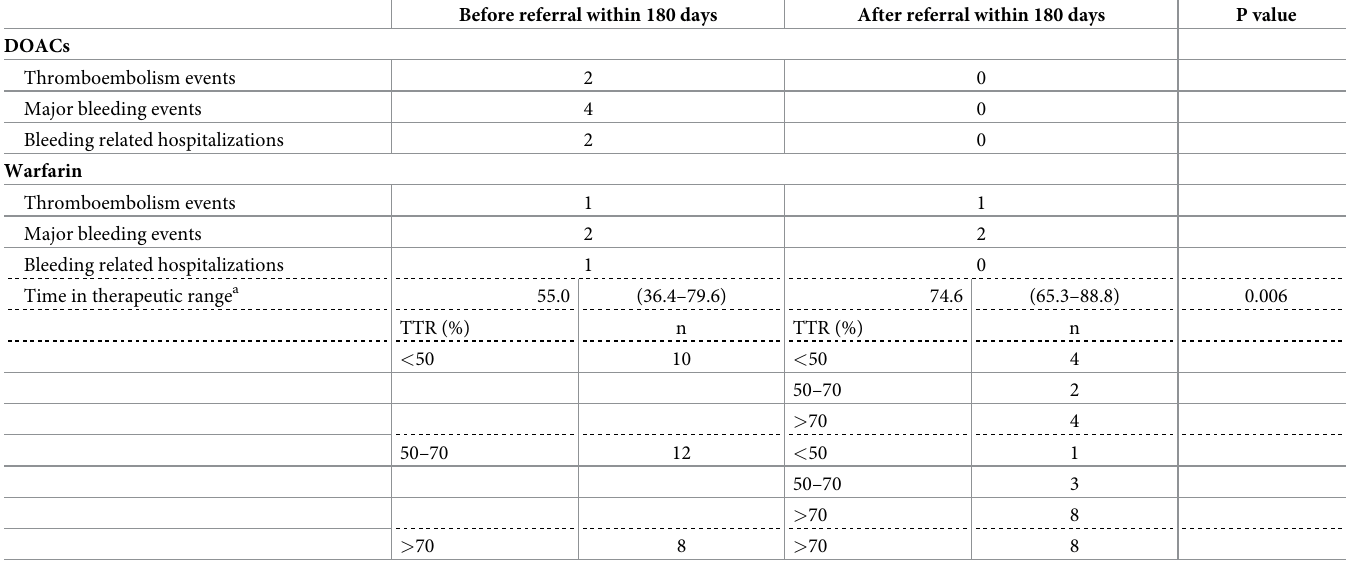
Table 4. DOACs and warfarin service